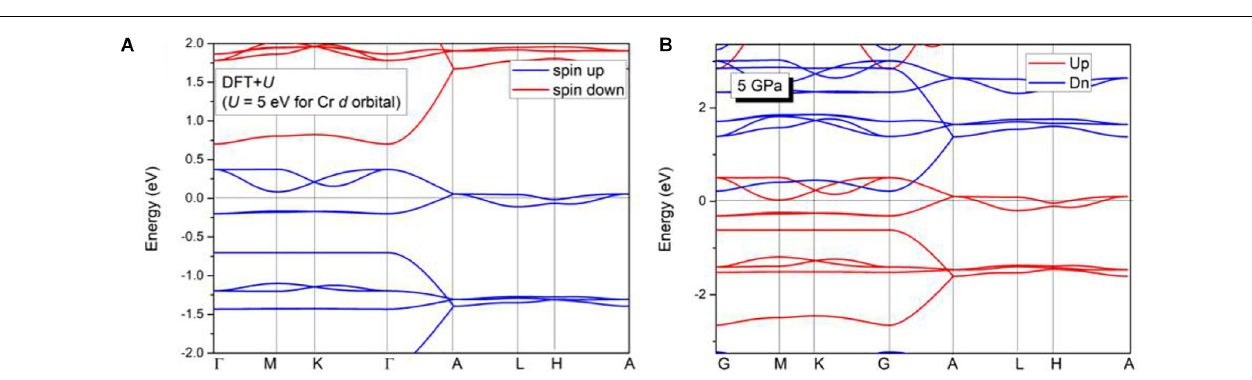
FIGURE 5 | Spin-polarized band structures of CsCrCl 3 system with DFT + U method (A) and with uniform strain (B) ,